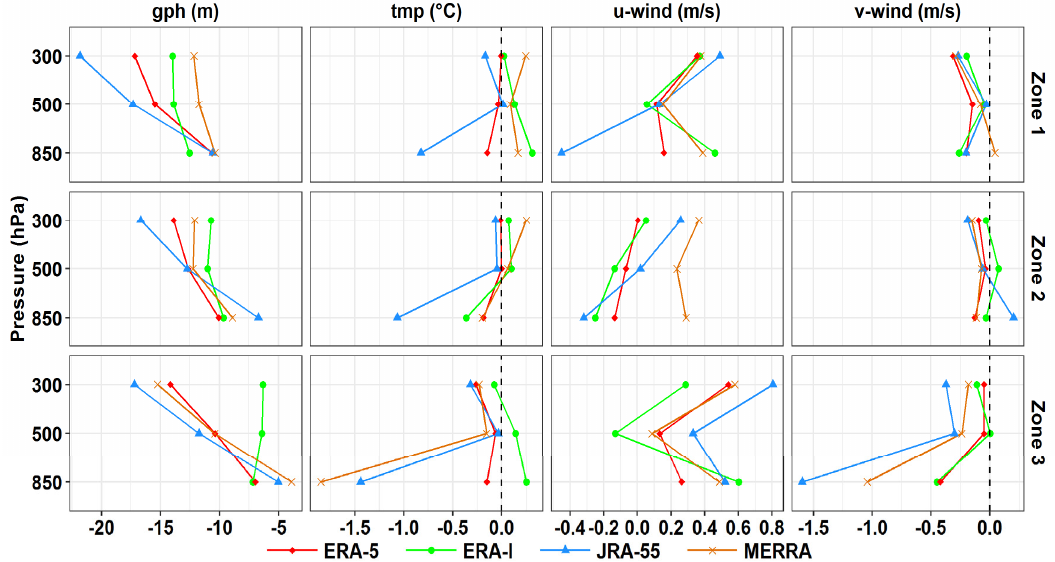
Figure 3. Vertical profiles of annual mean biases (reanalysis–radiosonde) of gph (m), tmp (°C), and horizontal wind (m/s).